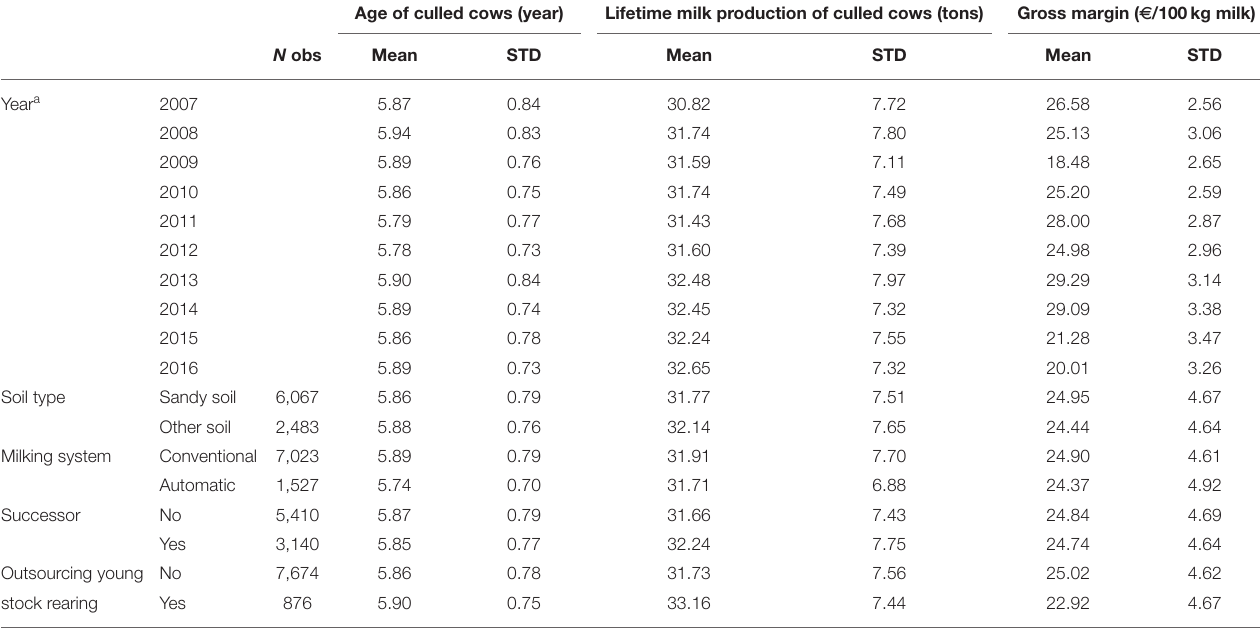
TABLE 3 | The number of observations, mean and standard deviation (STD) of average longevity variables (age and lifetime milk production of culled cows) and gross margin per categorical